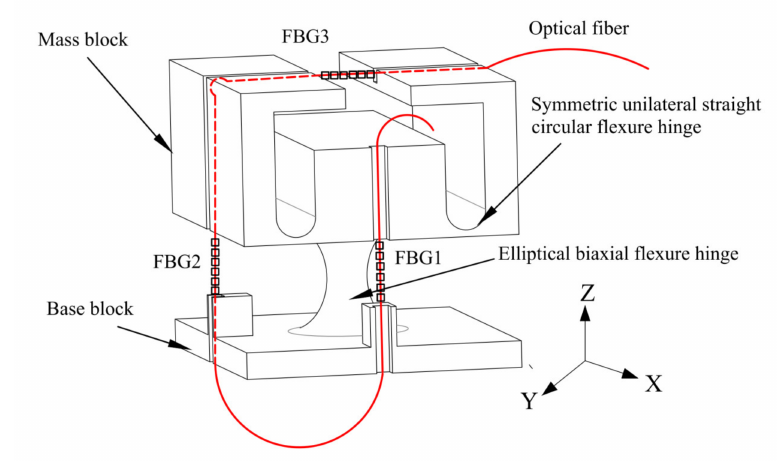
Figure 1. Three-dimensional accelerometer oscillator structure.